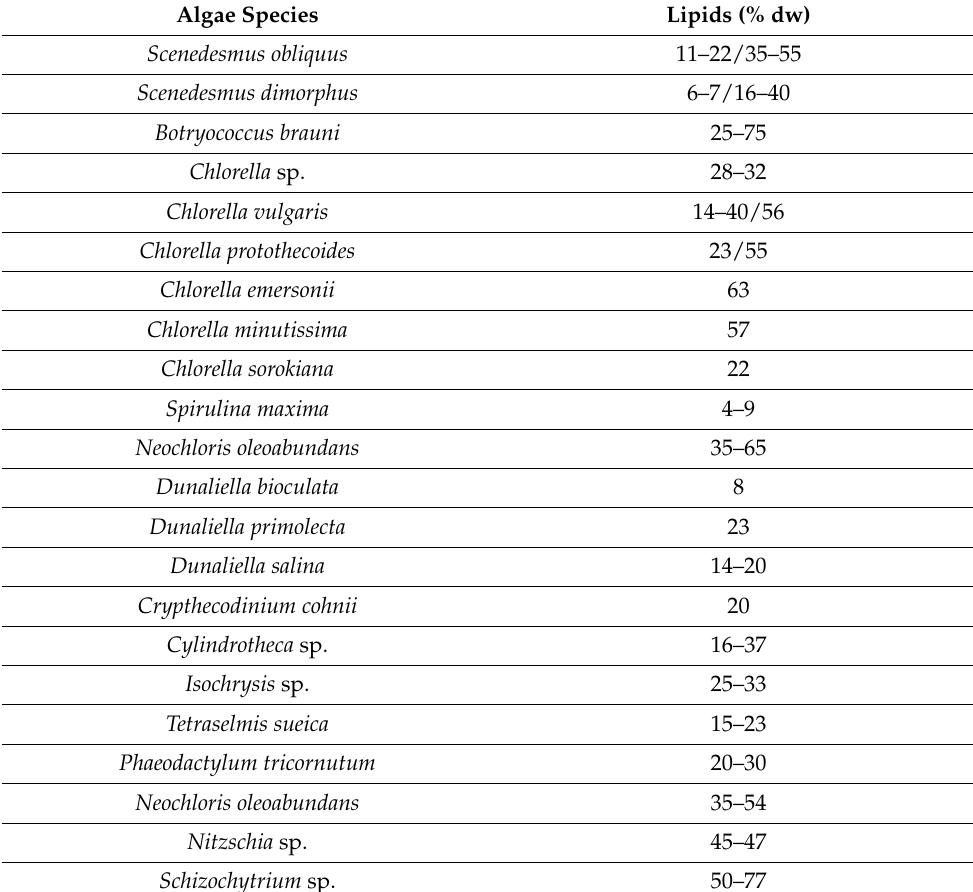
Table 1. Lipid content of selected algae species presented as dry weight percentage [37–45]. Algae Species Lipids (%